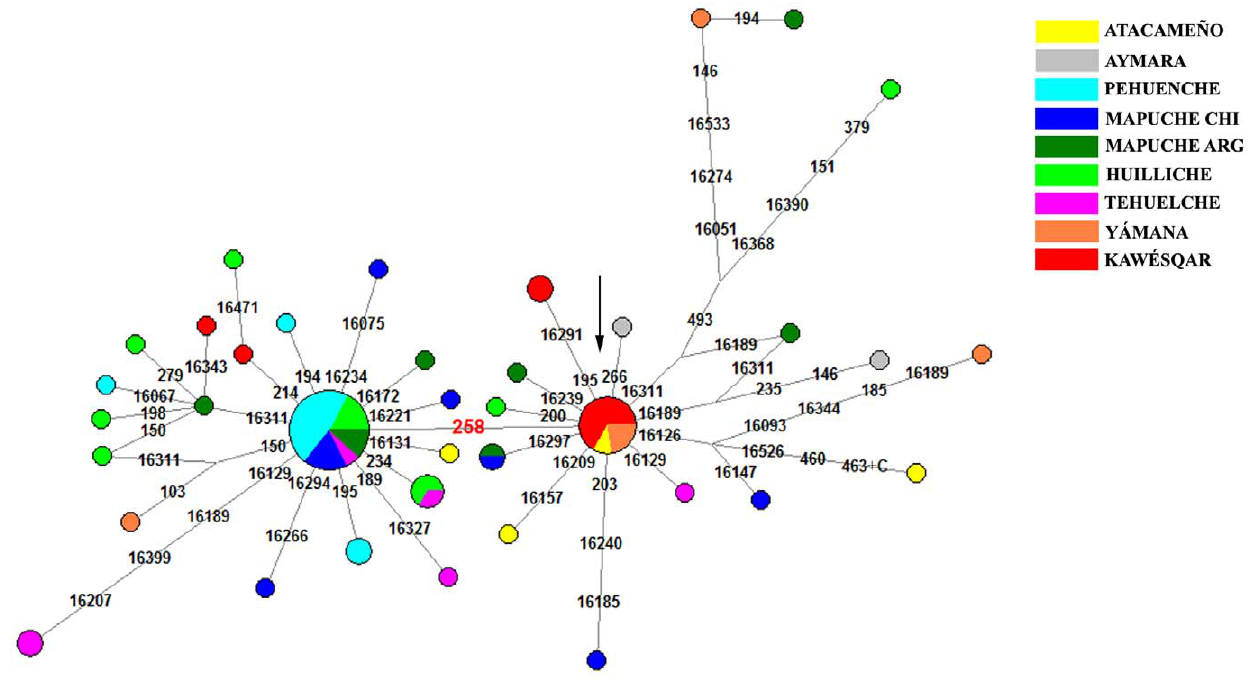
Figure 4. Network for the C1 haplogroup. The arrow shows the C1b nodal, characterized by rCRS differences at 16223-16298-16325-16327-073- 249d-263-290d-291d-315 + C-489-493-522d-523d. We also show the C1b13 lineage, characterized by the 258 polymorphism plus C1b core.